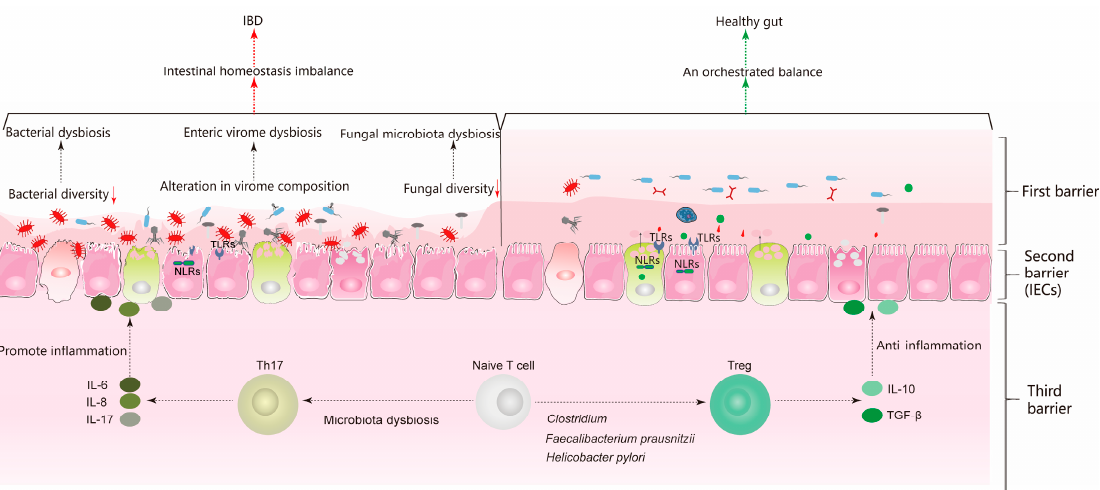
Figure 2. Alteration of the intestinal homeostatic balance promotes the pathogenesis of inflammatory bowel disease (IBD). During homeostasis in healthy intestines, gut microbes induce an immune tolerance phenotype. In contrast, the key features of homeostasis imbalance are microbiota dysbiosis and immunological dysregulation. Microbiota dysbiosis involves the excessive reproduction of potentially pathogenic microorganisms, which can erode the intestinal mucosa and increase intestinal permeability, thus promoting the overactivation of the adaptive and innate immune system and driving chronic inflammation. Moreover, microbiota dysbiosis can induce imbalance of the Treg / Th17 axis, leading to further inflammatory responses in the intestinal tissue. However, some gut microbiota (e.g., Clostridium, Faecalibacterium prausnitzii, and Helicobacter pylori ) favors the development of Treg